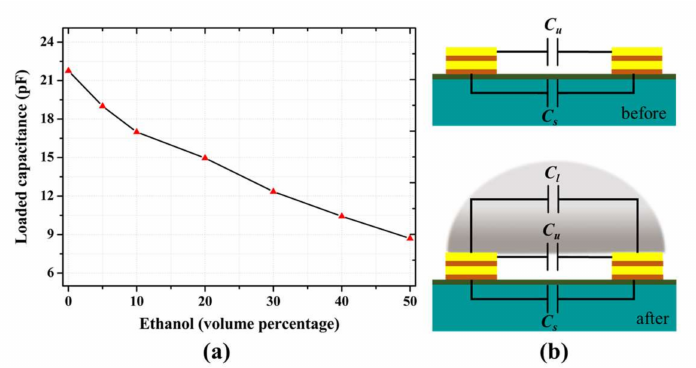
Figure 5. ( a ) Variation in the capacitance as a function of the ethanol concentration. ( b ) Overall capacitance before (top) and after (bottom) the introduction of sample. The introduction of the sample increases the capacitance between the two resonator